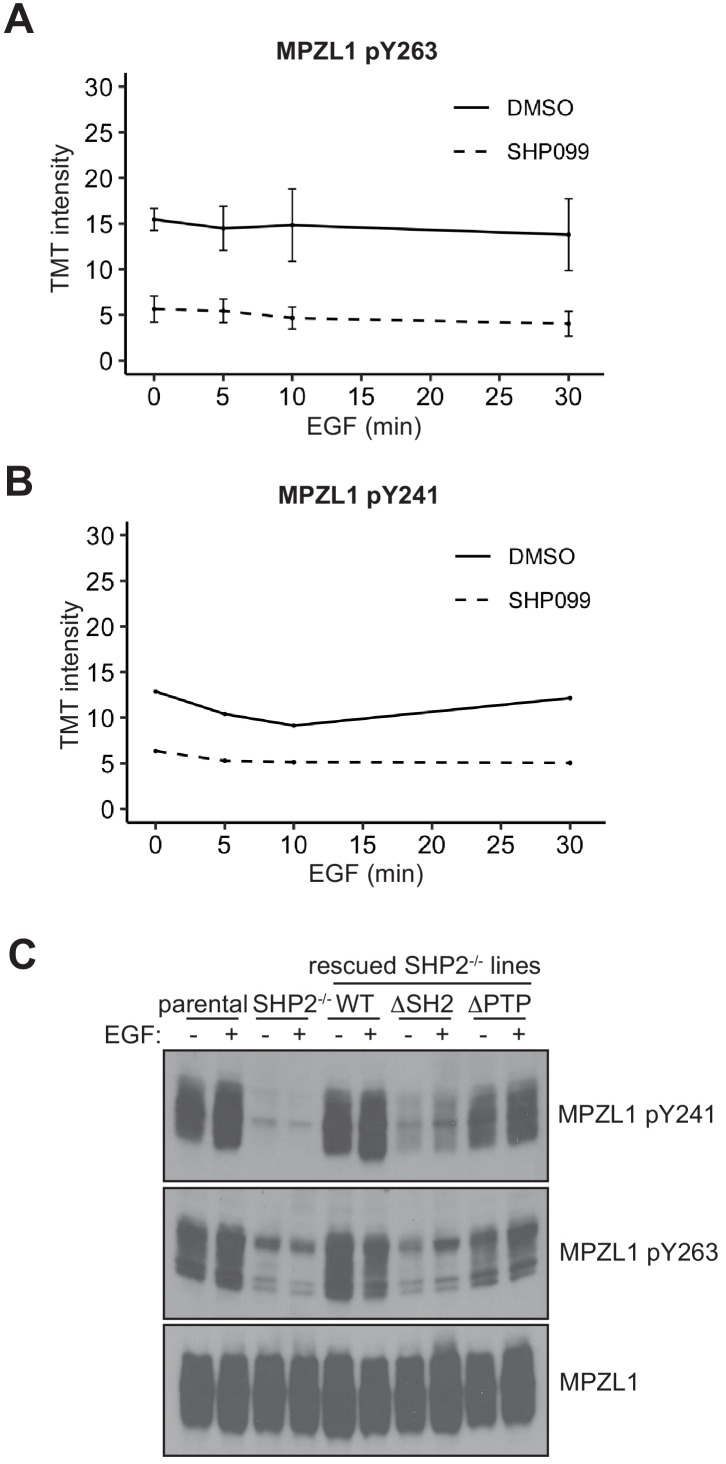
SHP2 protects MPZL1 phosphotyrosine residues.(A, B) TMT signal-to-noise intensities of MPZL1 peptides showing phosphorylation changes between DMSO- (solid line) and SHP099-treated (dotted line) groups. (C) Unstimulated or EGF-stimulated parental-, SHP2 knockout-, and SHP2 knockout stably expressing wild-type, PTP, and SH2 U2OS cell lines were blotted for pY263-MPZL1, pY241-MPZL1, and MPZL1. Western blot results are representative of at least two independent biological replicates.Figure 5—figure supplement 1—source data 1.Table showing TMT relative abundance values for Y263 of MPZL1.Figure 5—figure supplement 1—source data 2.Table showing TMT relative abundance values for Y241 of MPZL1.